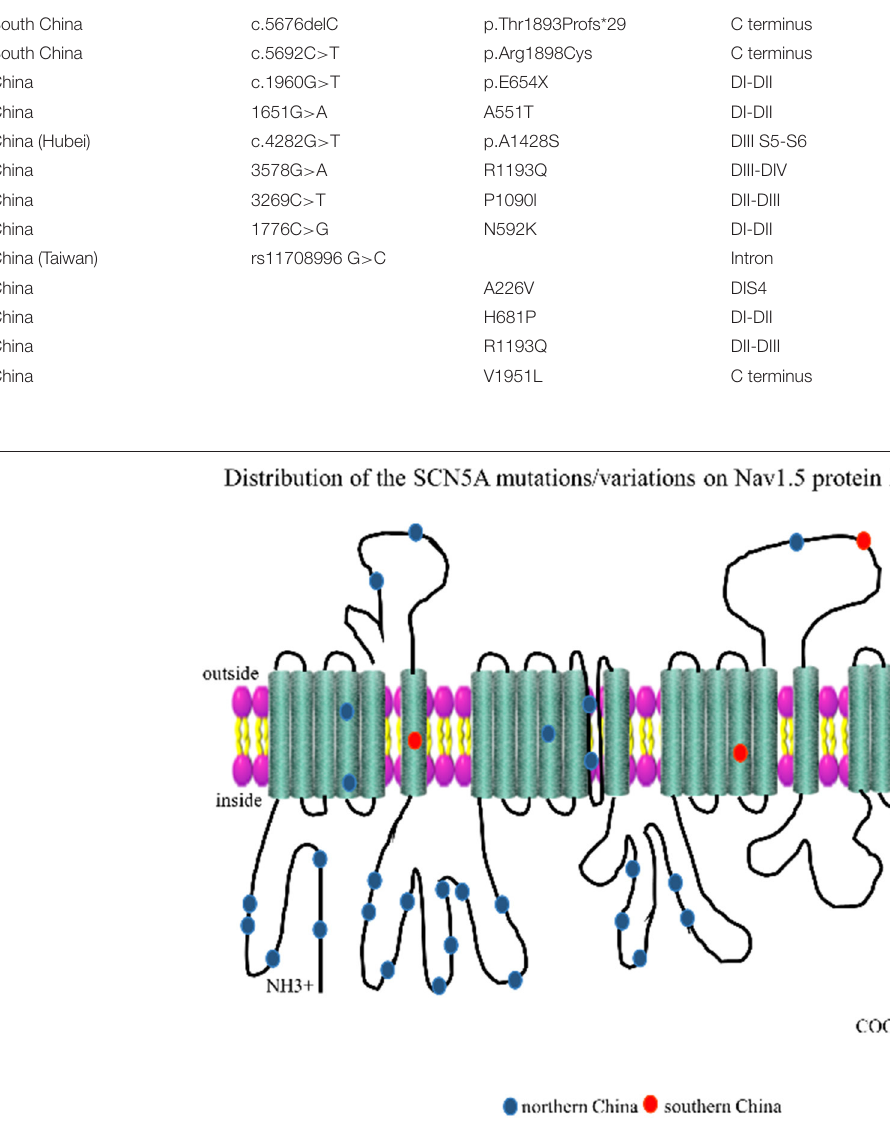
FIGURE 2 | Representation of SCN5A gene mutations/variations was labeled on the corresponding location of the Nav1.5 protein structure. The blue dots represented mutations/variations from southern China. The red dots represented mutations/variations from northern China.